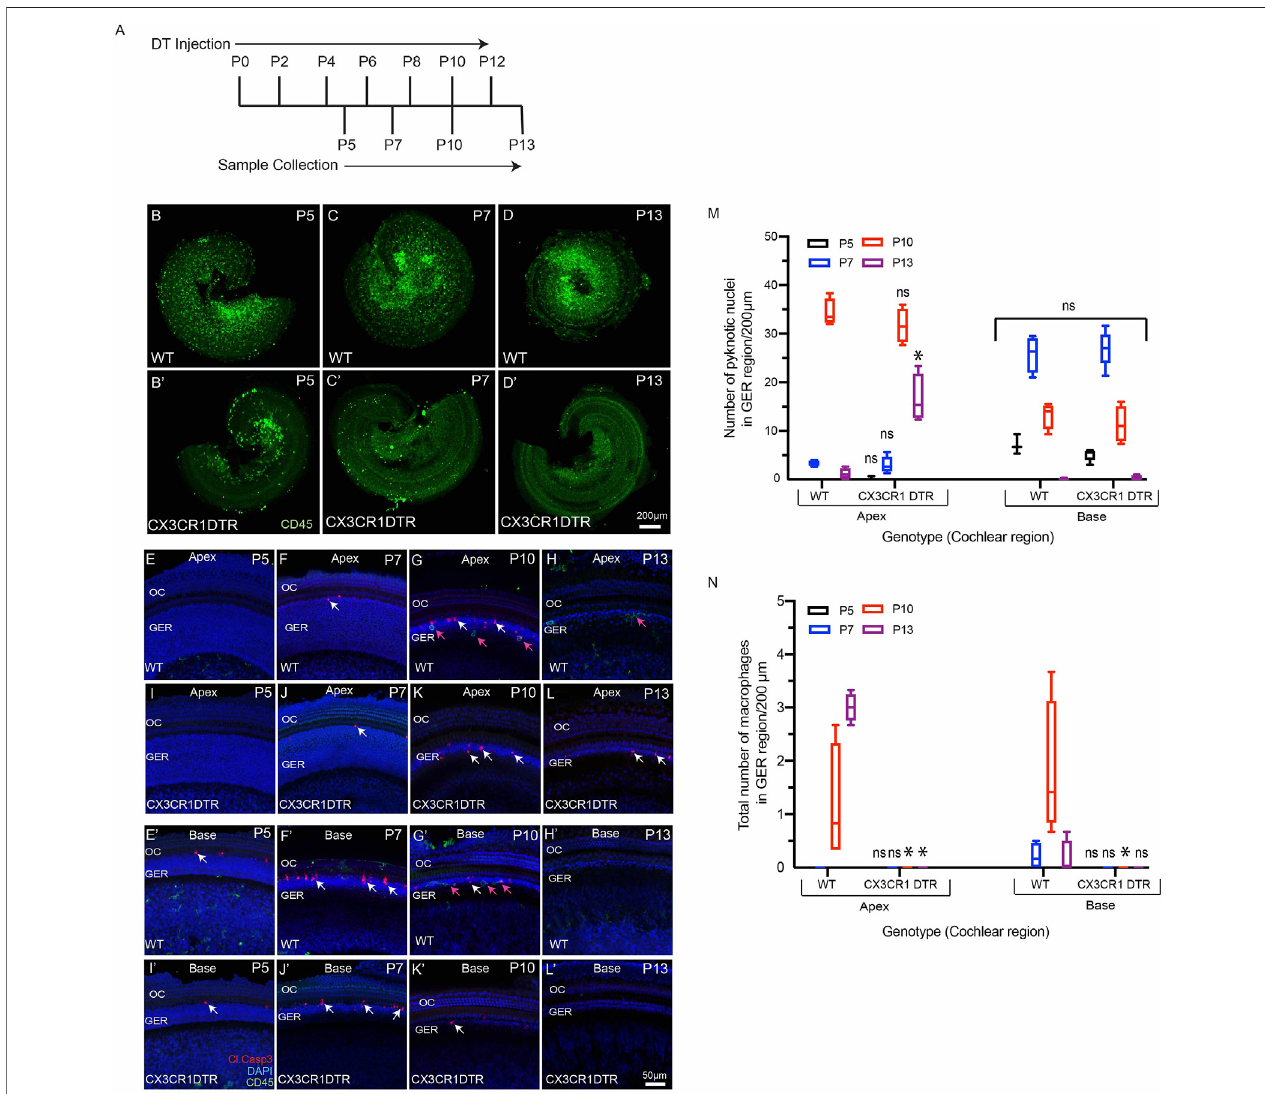
FIGURE5| Depletionofmacrophages inthecochlea ofneonatalCX3CR-DTRmice. (A) Treatmentand sample collection timeline. (B – D 9 ) Cochlearwholemounts showing depletion of macrophages (Green: CD45) following DT treatment. (E – L 9 ) Sensory epithelium of developing cochleae showing occurrence of cell death (red, cleaved caspase-3, white arrows) in normal and DT-treated cochleae. Although DT treatment eliminated macrophages in the cochleae of CX3CR-DTR mice, normal patterns of cell death were observed. (M) Number of pyknotic nuclei (blue: DAPI) in the GER region of developing cochleae. (N) Quanti fi cation of macrophages in the GER region of developing cochleae. Treatment with DT led to a large reduction in macrophage numbers. Images in (B – D 9 ) were taken using × 5 objective lens and images in (E – L 9 ) were taken using × 20 objective lens. Abbreviations: OC: Organ of Corti, GER: Greater Epithelial Ridge (*p: p value < 0.05, relative to WT, ns: not signi fi cant. (N (cid:2) 3 –